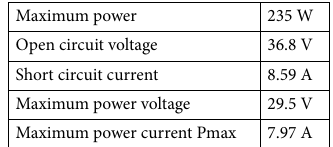
Table 2. Csun 235-60p PV panel characteristics.